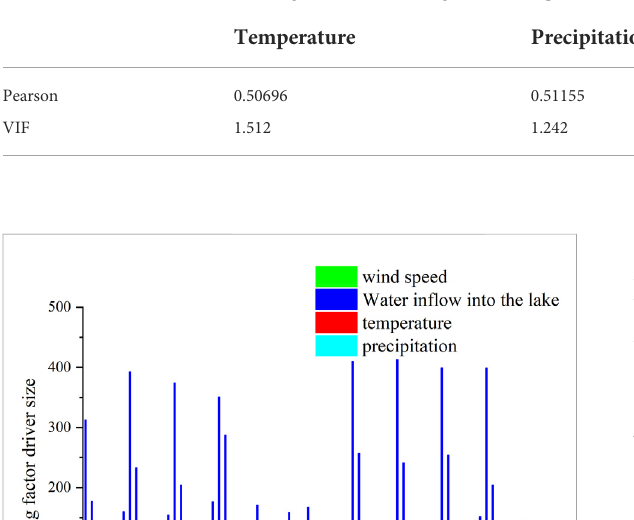
TABLE 1 Correlation and collinearity between monthly meteorological elements and monthly average area of Ebinur lake from 2011 to 2020.